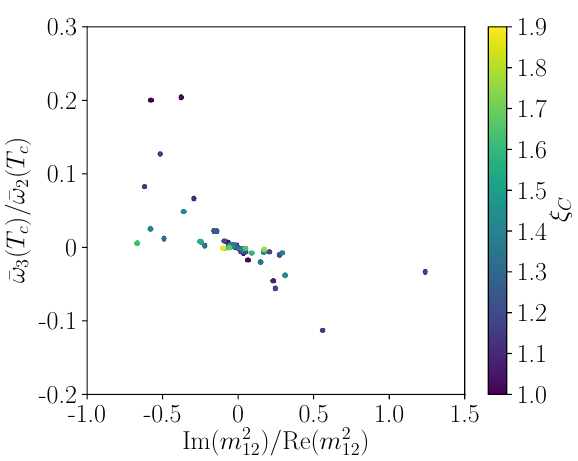
Figure 1 . Type I, H 1 = h : the value (cid:22) ! 3 ( T c ) = (cid:22) ! 2 ( T c ) at the critical temperature T c versus Im( m 2 ) = Re( m 2 ) = 0 at T = 0 for points with a strong PT. The colour code indicates the 12 12 6 size of (cid:24) c